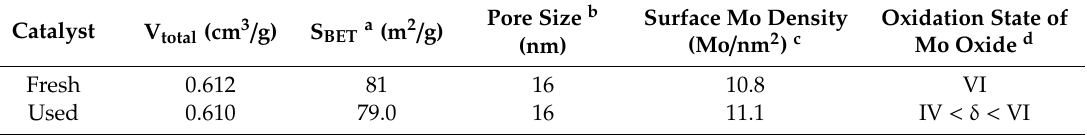
Table 3. Physico-chemical properties of the